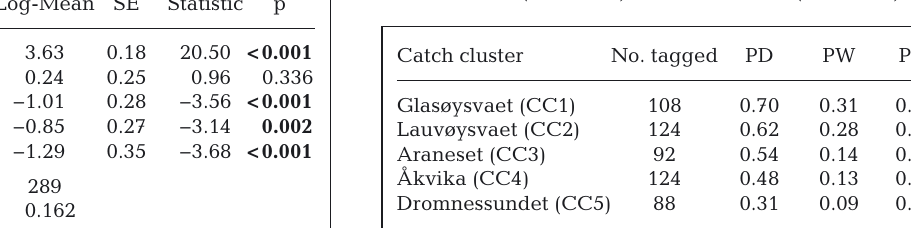
Table 6. Negative binomial model on the number of days cod spent at a salmon farm as a function of the categorical variable catch cluster (CC). The treatment contrast of R was used with the intercept representing the value for CC1 (Glasøysvaet). Square brackets indicate a categorical vari- able tested against the reference variable. Letters show the results of Tukey’s post hoc tests, with different letters indi- cating significant differences (p < 0.05). Significant p-values (p < 0.05) are in bold Table 7. Proportion of cod from different catch clusters (CCs) that were detected at a salmon farm for 1 day (PD), at least 7 d (1 wk; PW) and at least 30 d (1 mo;